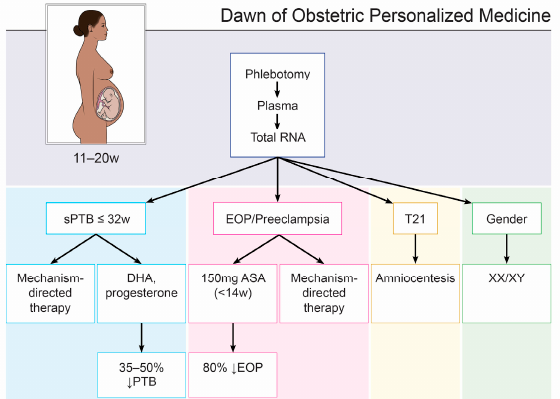
Figure 2. Dawn of Obstetric Personalized Medicine. Women may soon have the opportunity to choose screening based on a single plasma sample of cell-free RNA as early as the first trimester using a group of already validated tests and then initiate targeted therapy as desired.